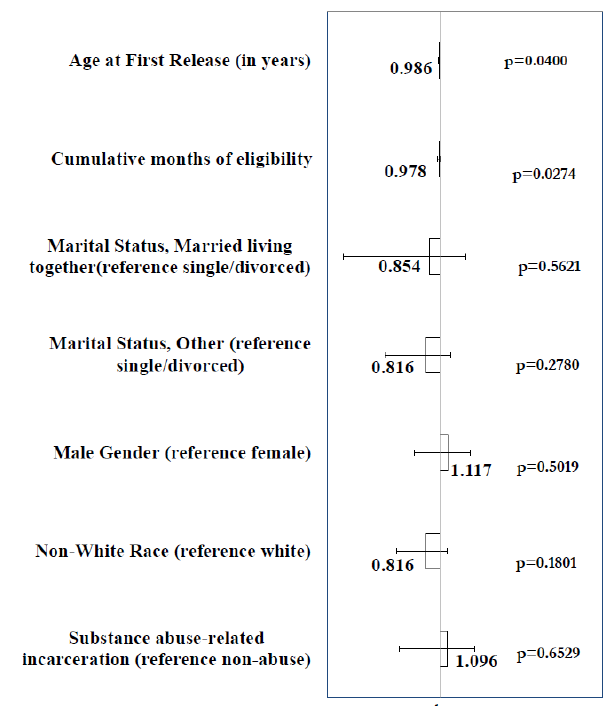
Figure 3. Three-year Survival Analysis Hazard Ratios and 95% Confidence Intervals for Eligibility at Re-incarceration (Eligibility Measure